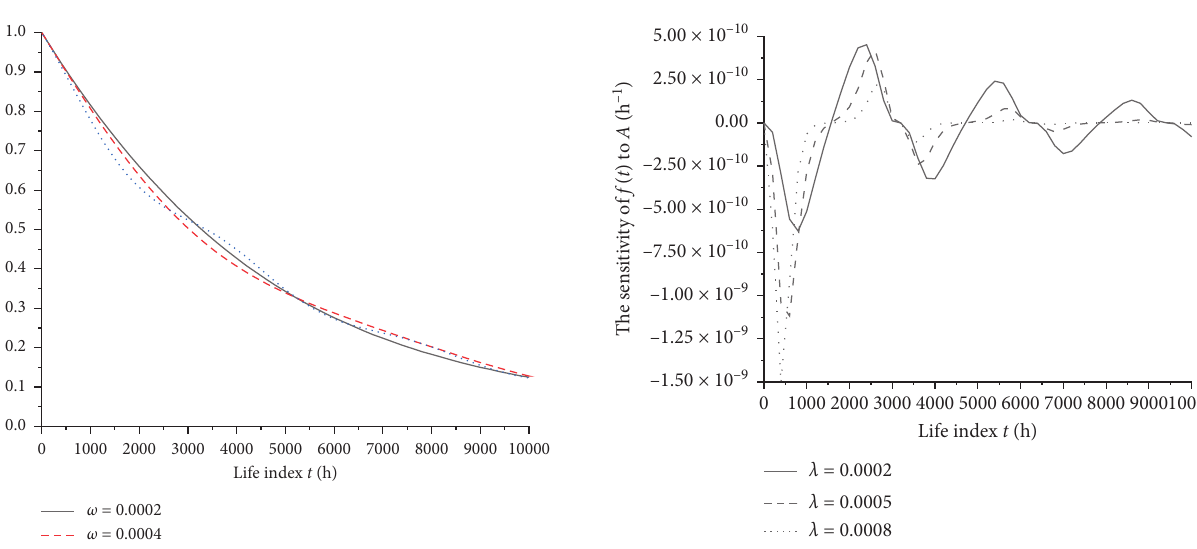
Figure 19: The sensitivity of f ( t ) to A ( λ � 0.0002/0.0005/0.0008).